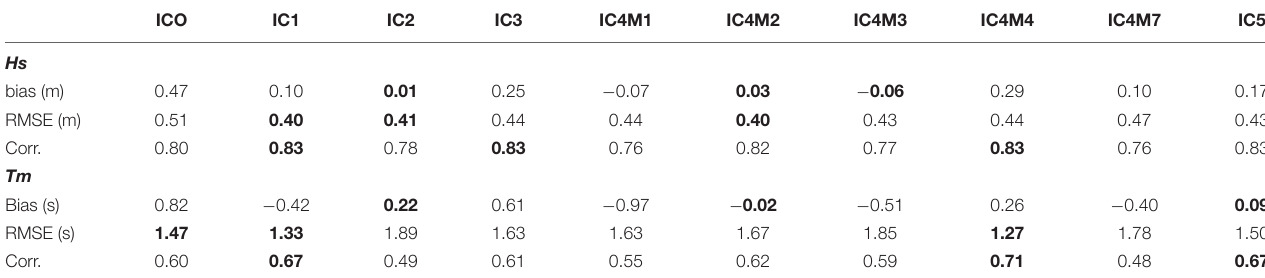
TABLE 1 | Statistical values of H s and T m between the ST6 model simulations and buoy observations for the ice-covered condition. ICO IC1